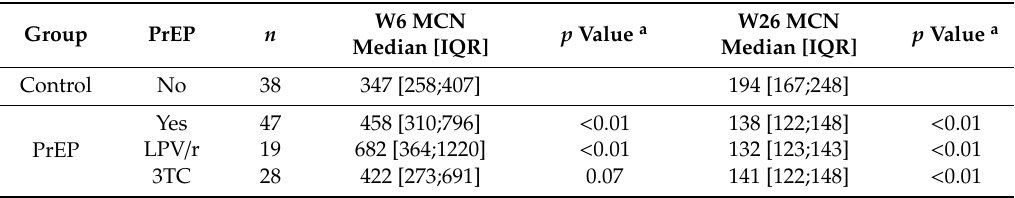
Table 5. mtDNA copy number per cell (MCN) at baseline (W6) and at W26 in South African CHEU from the control group and the PrEP